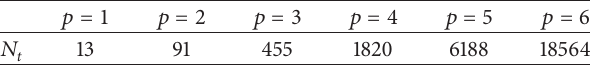
Table 1: The number of PCE terms with 𝑝 increasing ( 𝑛 = 12